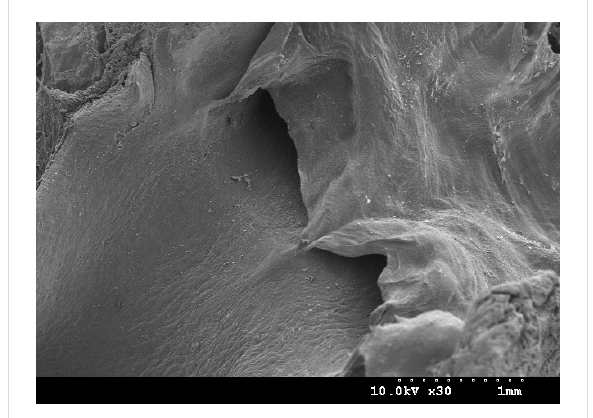
Figure 1: SEM image of the aortic valve of the